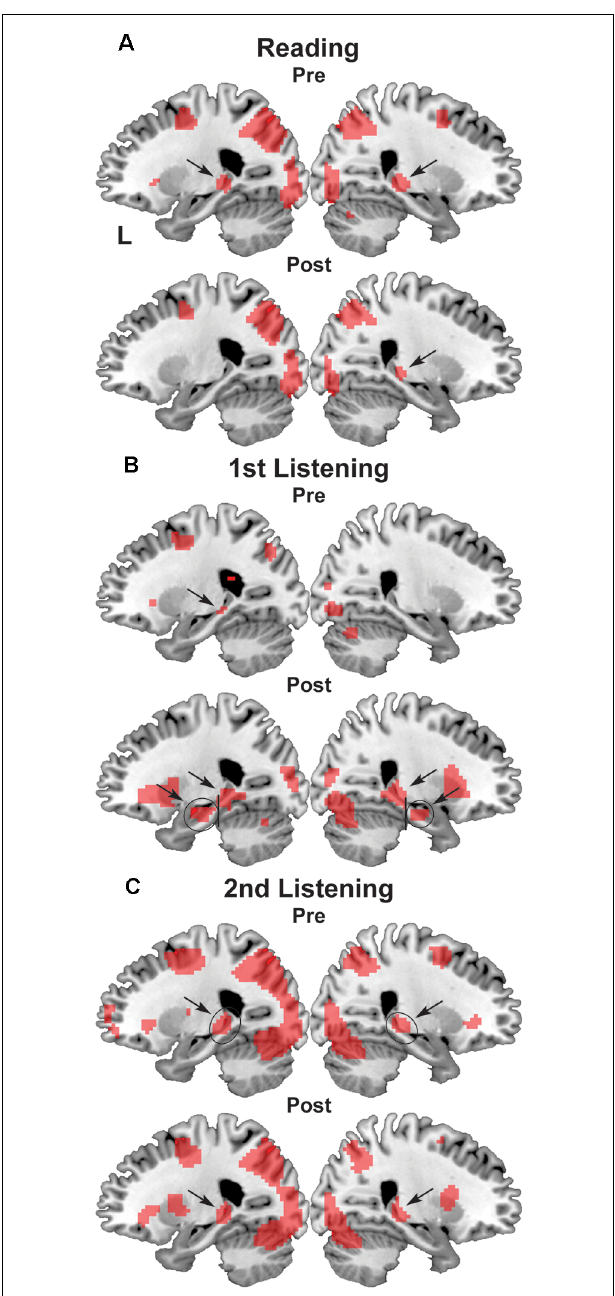
FIGURE 4 | Activation in the bilateral hippocampus. (A) Reading events, (B) first listening events, and (C) second listening events. On the parasagittal planes ( x = ± 24), each arrow denotes the posterior or anterior hippocampus. ROIs are denoted with black ellipses.